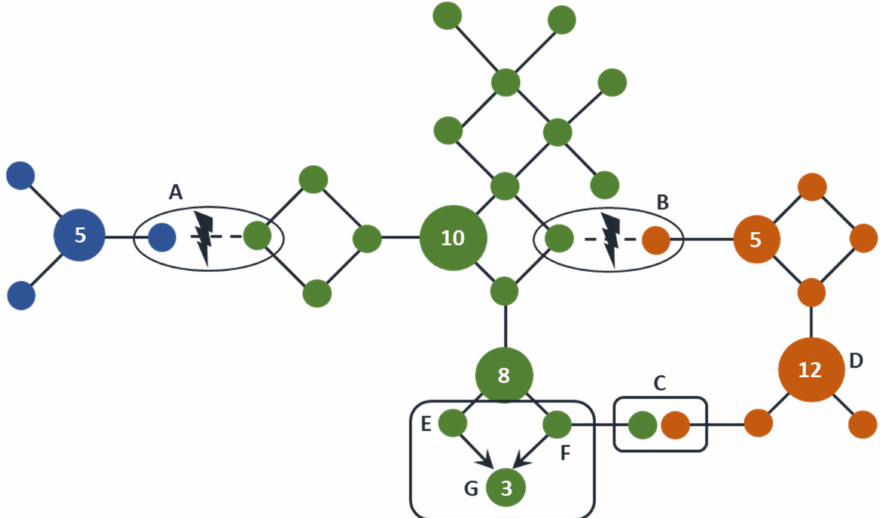
Figure 2. Y-STR haplotypes shared IBS and IBD. In this hypothetical set of 60 Y-chromosomes, a number of Y-STRs and Y-SNPs have been genotyped and connected into a network by single STR mutation steps. Each solid circle represents a unique Y-STR haplotype. The diameter of each circle represents the relative frequency of these haplotypes, further indicated with numbers inside. Unnumbered circles represent haplotypes that were observed once. The three different Y-SNP-defined haplogroups are shown in different colors. When, due to an SNP mutation, a new haplogroup arises (A and B) both the ancestral and derived Y-STR haplotypes are IBD, but at a different haplogroup. Similarly, also due to a series of independent and/or recurrent mutation events, two Y-STR haplotypes can be identical but occur on a different haplogroup background (C) or on a similar haplogroup background, but due to two parallel STR mutation events from different haplotypes (E and F), resulting in an identical haplotype (G). In both cases, they are shared IBS. Finally, males in a